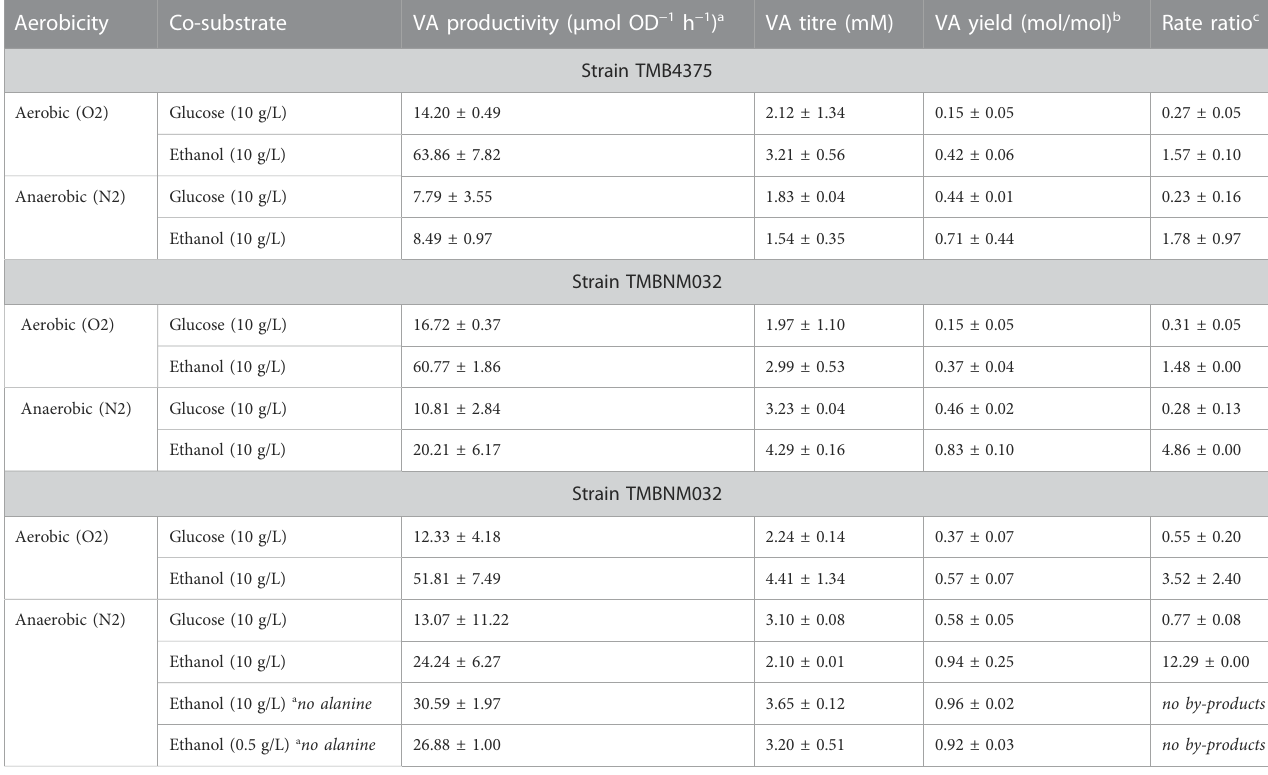
TABLE 2 Process parameters calculated for the different reaction conditions and strains during whole-cell conversion of vanillin to vanillylamine (VA).